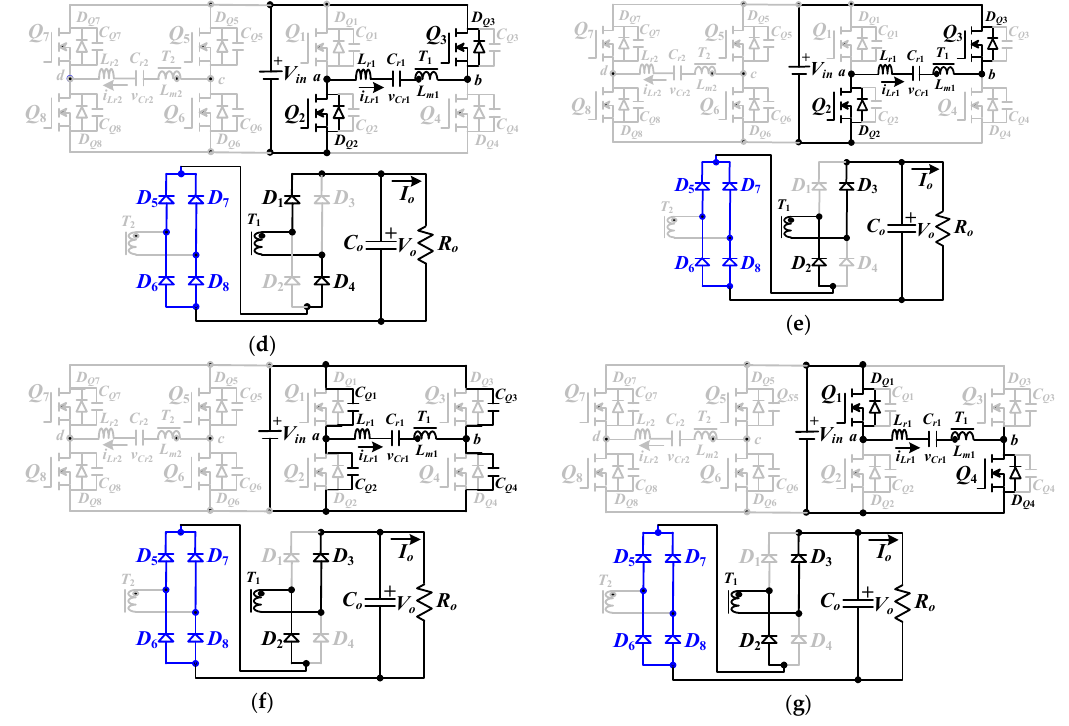
Figure 4. Circuit waveforms and equivalent circuits at high input voltage range and f s > f r, ( a ) PWM waveforms, ( b ) step 1, ( c ) step 2, ( d ) step 3, ( e ) step 4, ( f ) step 5, ( g ) step